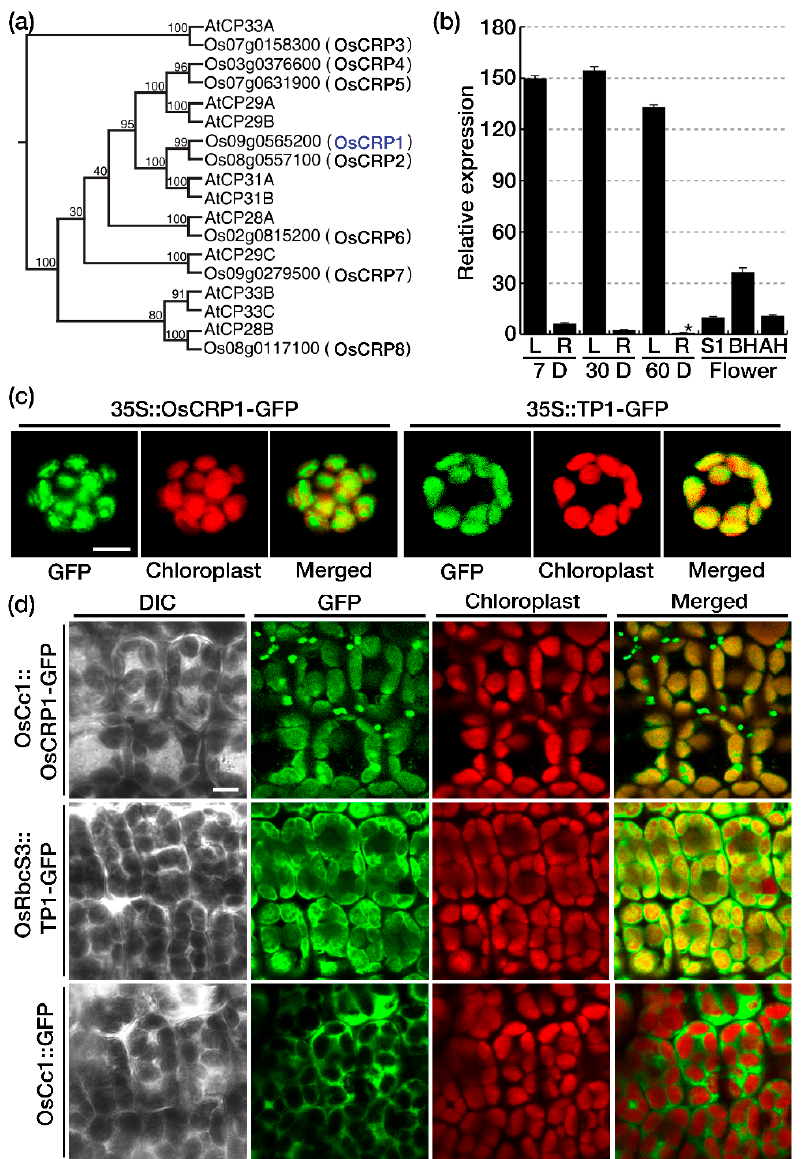
Figure 1. Expression patterns of OsCRP1 and subcellular localization of the corresponding protein.